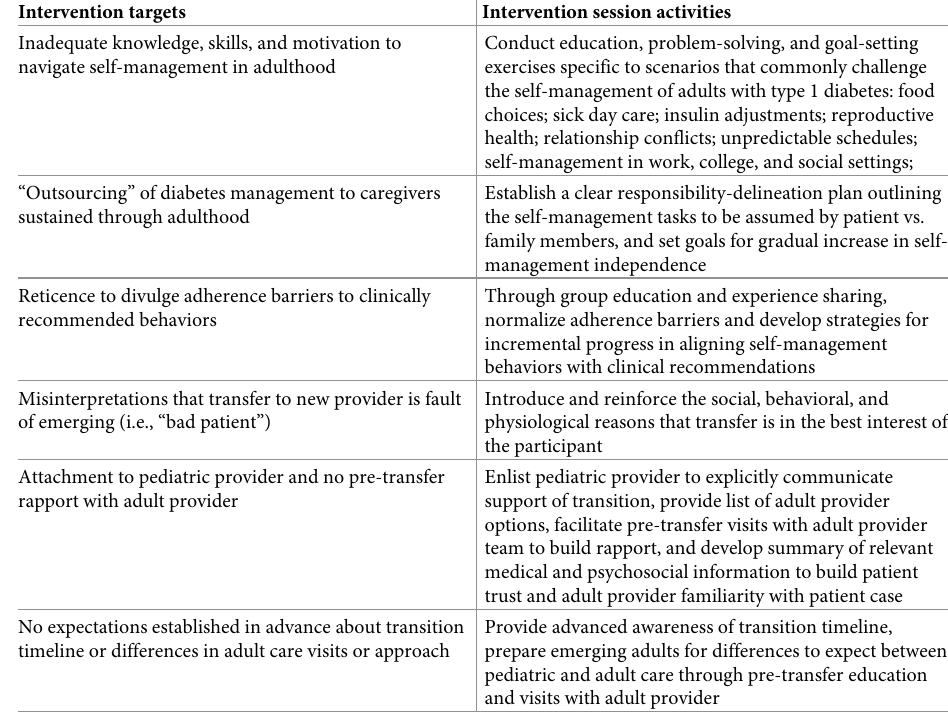
Table 1. Factors targeted through design of PATHWAY intervention to promote post-transfer clinic attendance and other health outcomes. Intervention targets Intervention session